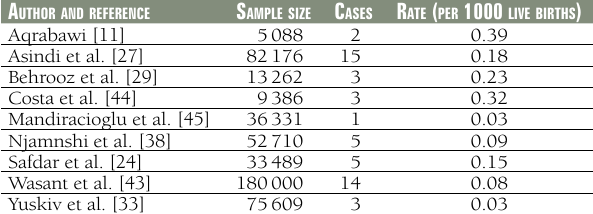
Table 7. Studies that reported rates for the burden of encepalo-